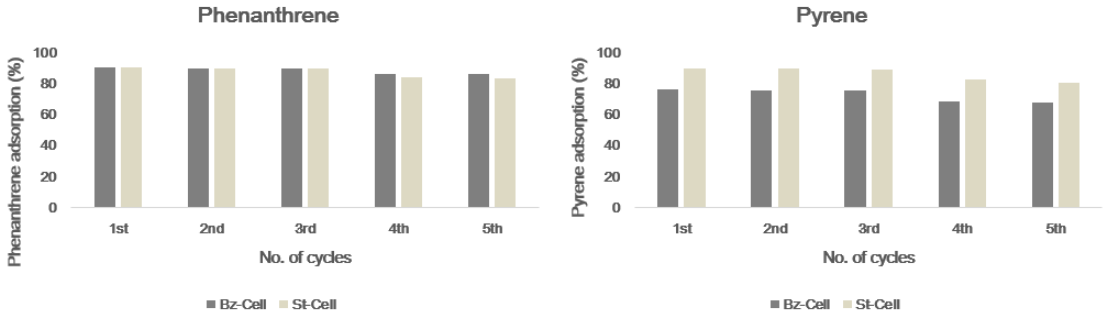
Figure 9. Recycling of Bz–Cell and St–Cell for the removal of phenanthrene and pyrene.